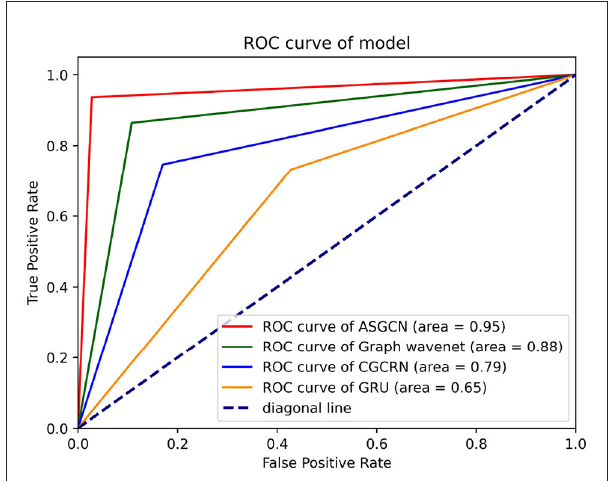
FIGURE7 ROC curve of different classification model. Each test selected three thresholds, i.e., max value, min value, and mid-value. Each threshold corresponded to a point (false positive rate, true positive rate). All coordinate points were connected to draw the ROC curve. The area represents